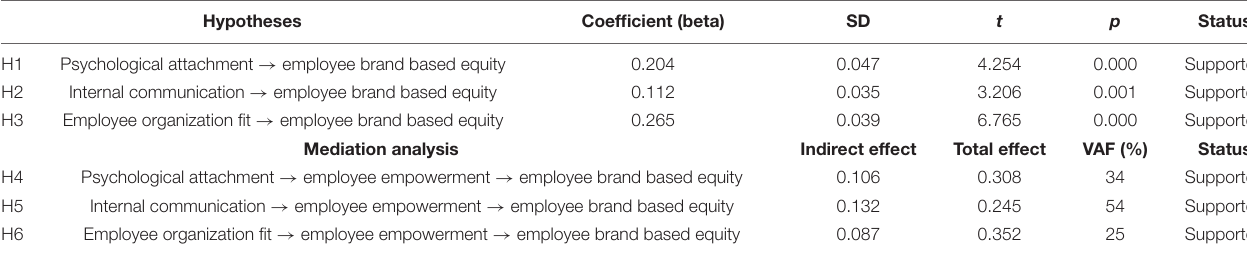
FIGURE 2 | Path estimates and outer loadings. TABLE 6 | Hypotheses